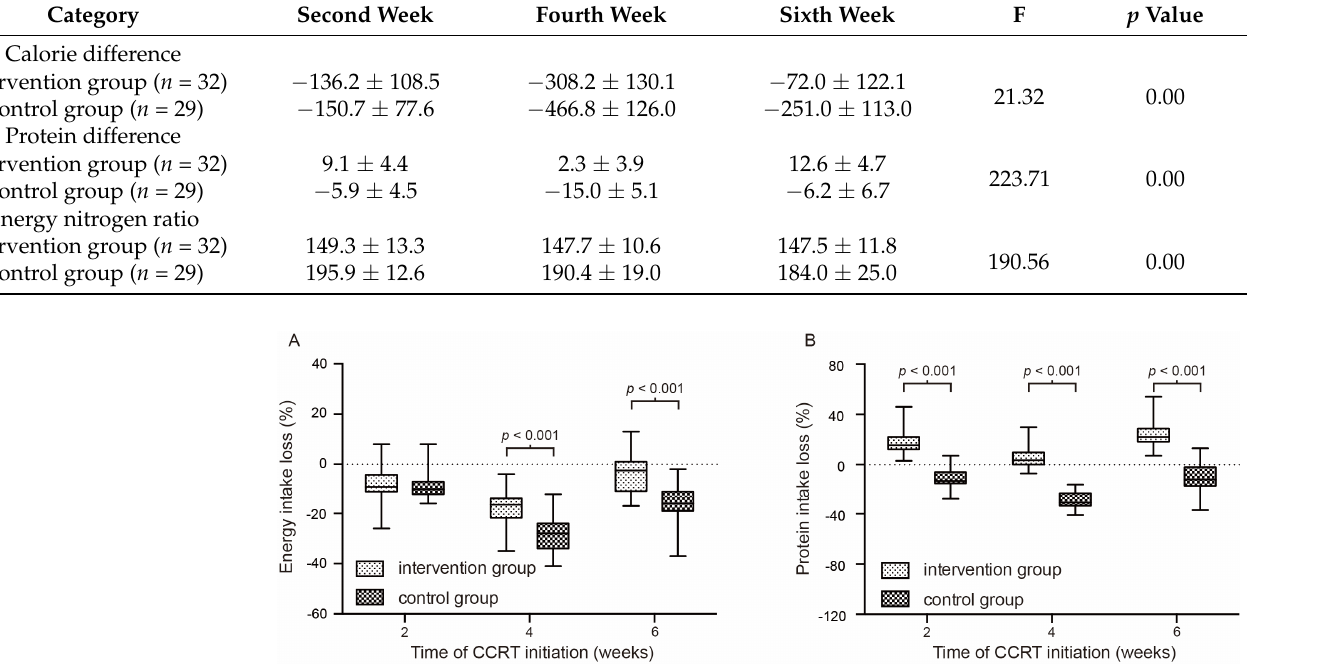
Figure 2. Percentage of energy intake change ( A ) and protein intake change ( B ) at different time nodes of concurrent chemo-radiotherapy.